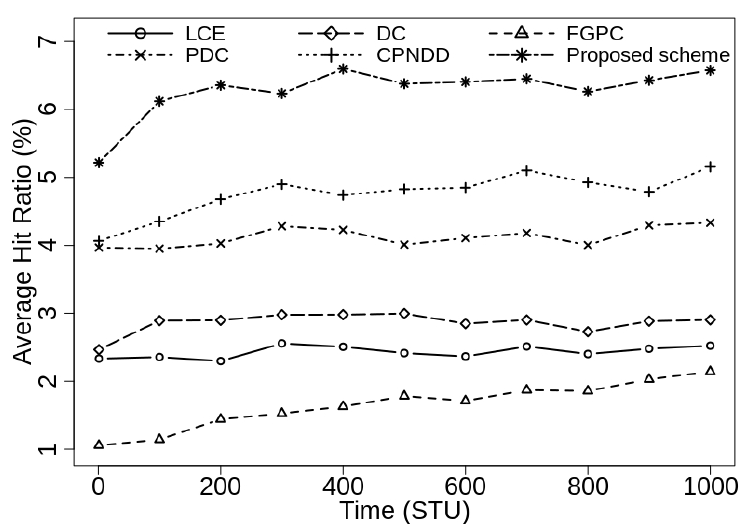
Figure 4. Comparison of cache hit-ratio (%) with λ = 50/s, | CS ( R i ) | = 50, α = 0.7, and | Ctlg | = 5000.